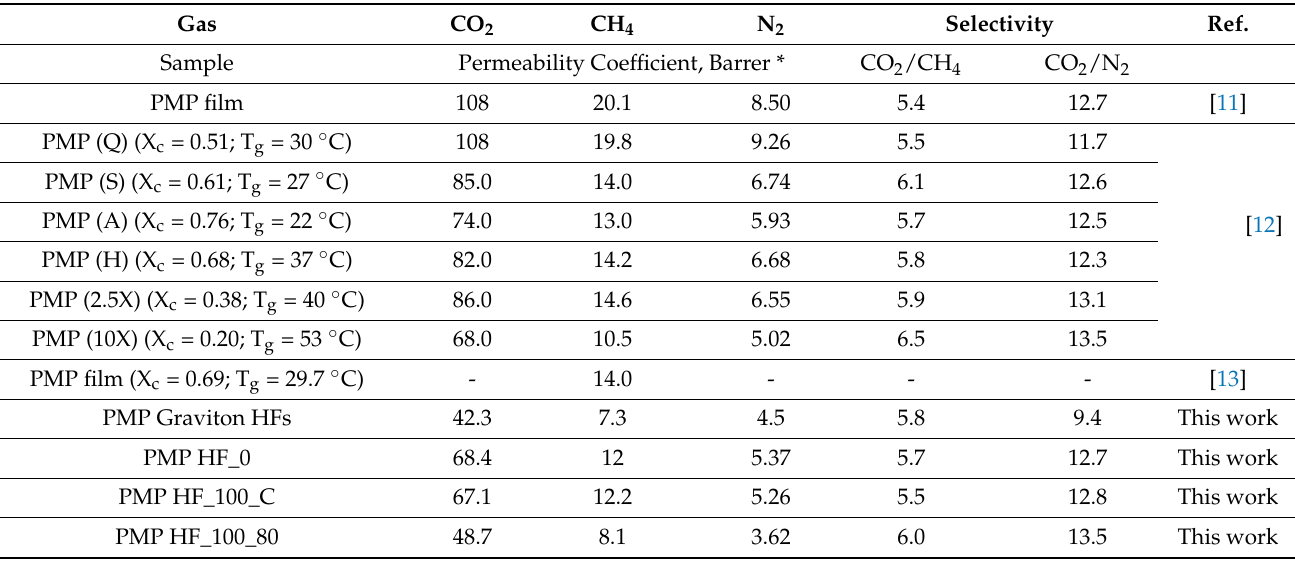
Table 4. Comparative table of gas permeability coefficients in PMP at 23–25 ◦